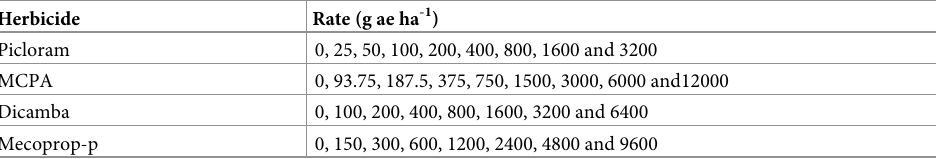
Table 1. Herbicides that were applied to clopyralid-resistant (OR) and clopyralid susceptible (OS) populations in dose-response